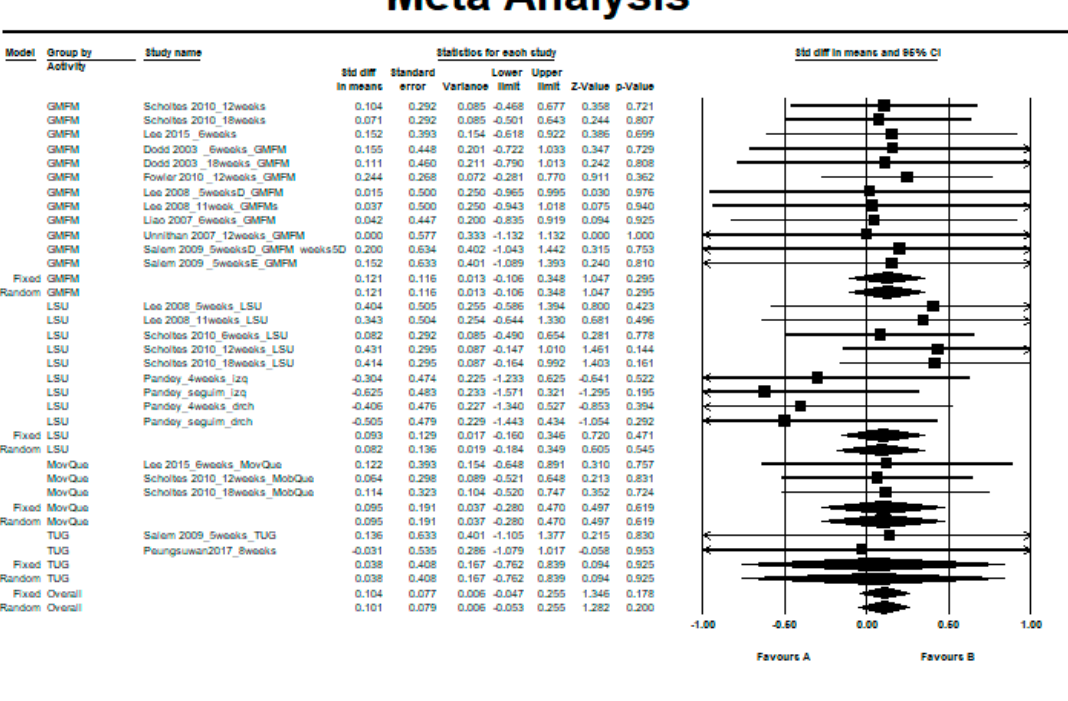
Figure 3. Pre–post intra-group difference in the control group. Table 5. Global heterogeneity in the control group: all scales and